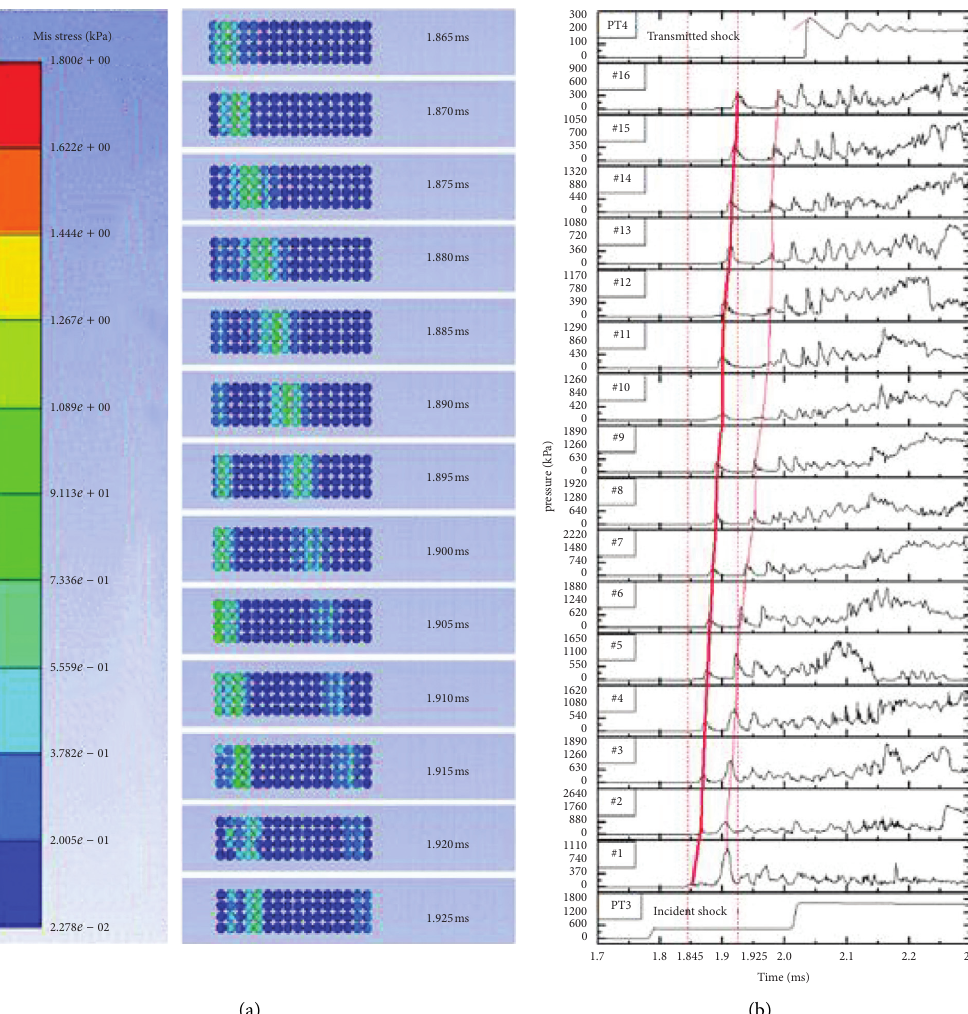
Figure 12: Stress distribution on the packed particles and stress